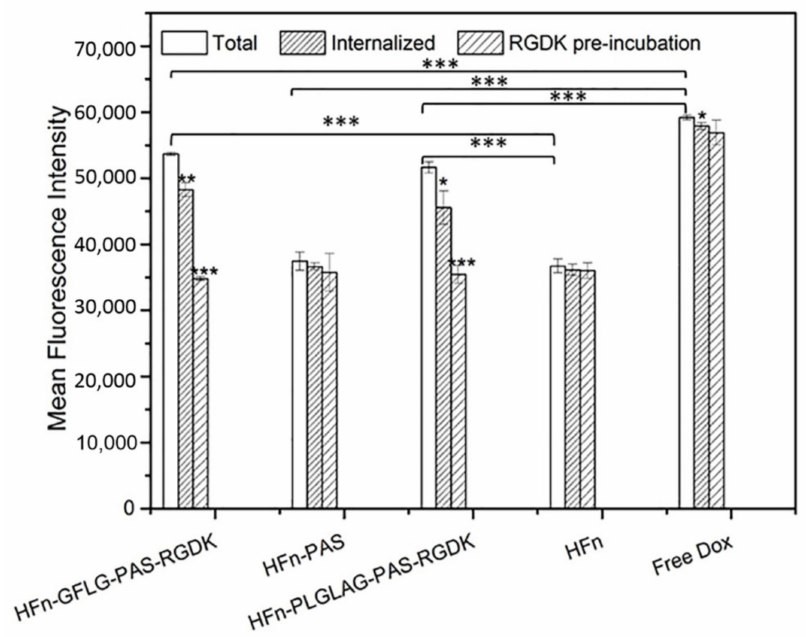
Figure 2. Mean DOX fluorescence intensity in 4T1 cellular uptake test. Data were represented as mean ± standard deviation ( n = 3), * p < 0.05, ** p < 0.01, *** p < 0.001. Symbol ‘*’ on top of column represents the significance of p value between this column and the white column (total DOX fluorescence) in the same